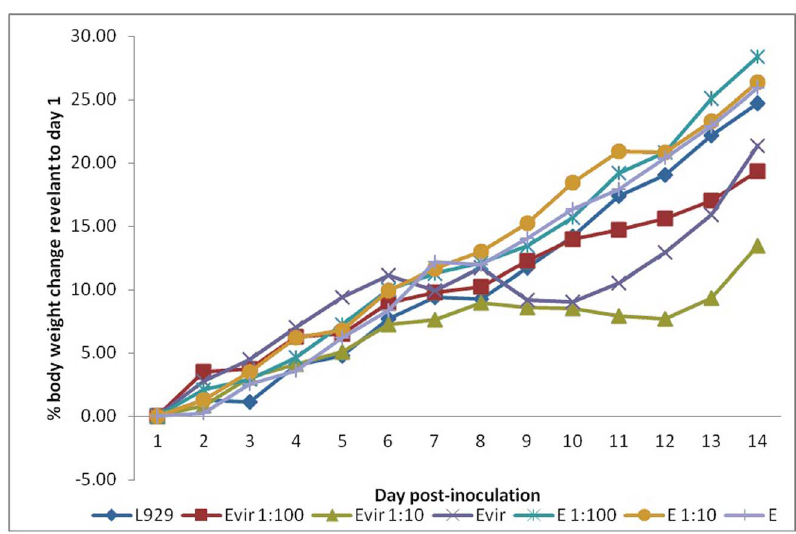
Figure 1. Body weight changes after infection with R.prowazekii strain E strain (DHW) and strain Evir at 10 4 , 10 5 , or 10 6 organisms. L929 cell suspension was used as control.